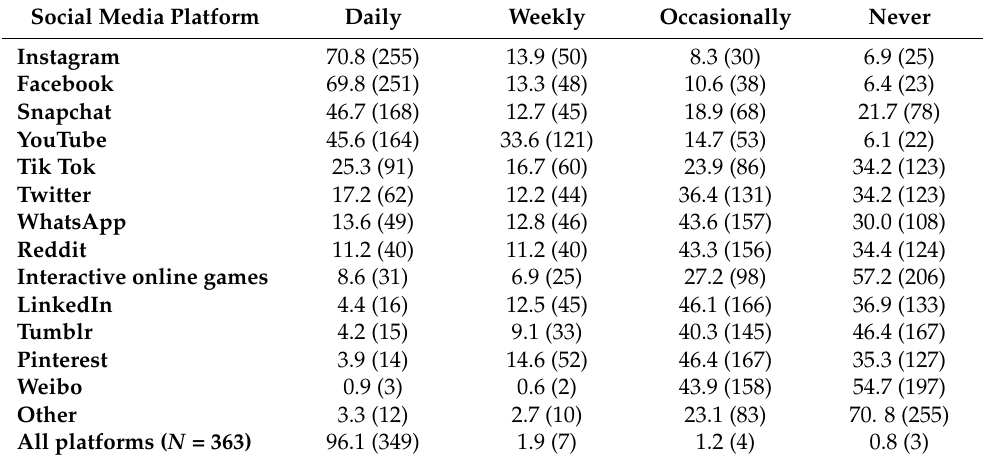
Table 5. Frequency of use (% ( n )) of different social media platforms ( N =